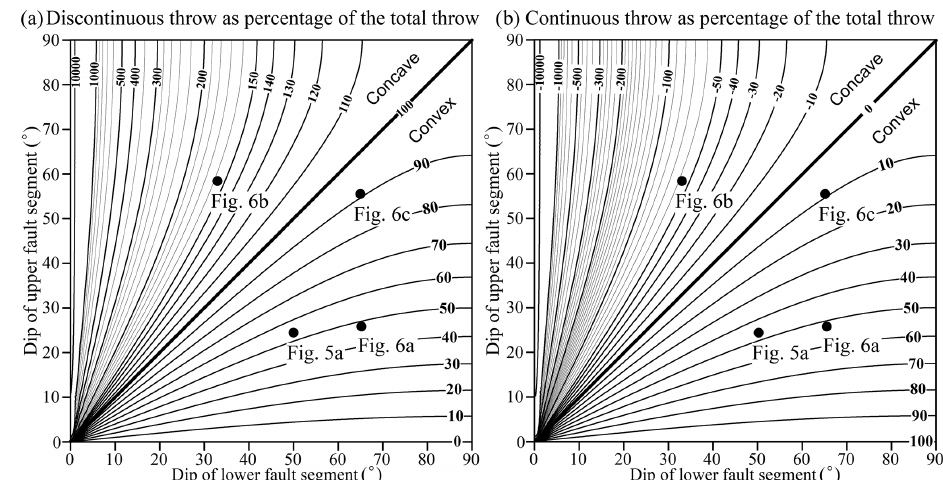
Figure 3. Graphs showing the modelled relationship between (a) the discontinuous ( T d ) and (b) the continuous ( T c ) throw, as a proportion of the total throw ( T t ), and the dips of the lower and upper fault segments of a sharp fault bend that comprises only two fault segments (i.e. Fig. 1). The geometries of the lower convex bends along the faults at Figs. 5a and 6a, the upper concave bend along the fault at Fig. 6b, and the convex fault bend at Fig. 6c are also plotted.